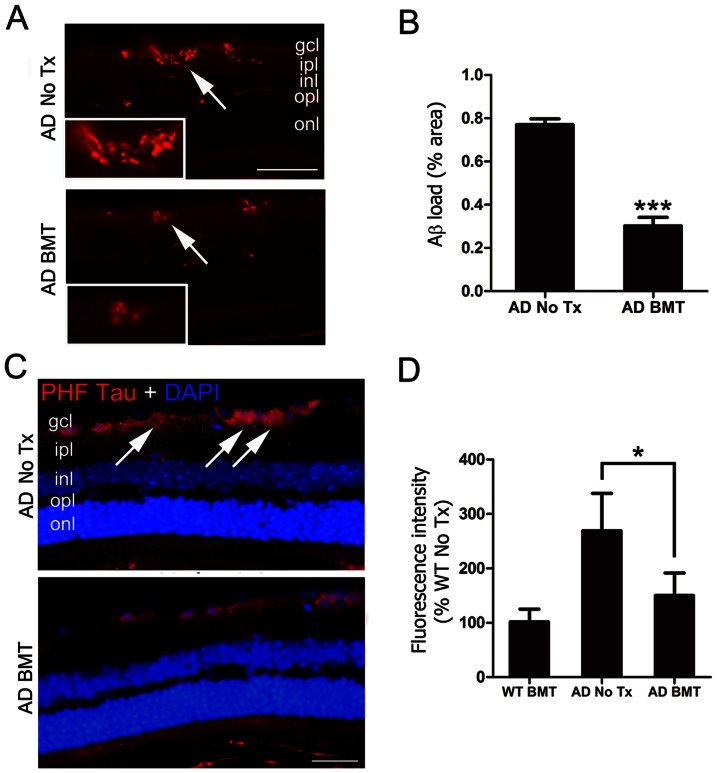
Aβ and PHF-tau are reduced in retina of APPswe-PS1ΔE9 BMT recipient mice.
A: Representative photomicrographs of Aβ deposition in non-transplanted, age-matched APPswe-PS1ΔE9 control retina (top, AD No Tx) or APPswe-PS1ΔE9 that received BMT (bottom, AD BMT) stained with anti-Aβ antibody and visualized with Cy3-conjugated secondary antibody (red). Region of inset is indicated by arrows. Scale bar  = 50 µm. B: Quantitative analysis of Aβ immunofluorescence using a standardized digital thresholding protocol demonstrated significant reduction in retinal Aβ in BMT APPswe-PS1ΔE9 mice compared with non-transplanted APPswe-PS1ΔE9 control mice (***P<0.001, n = 6, student's t test). C: Representative photomicrographs of PHF-tau immunofluorescence in retinal ganglion cell layer (RGCL) (arrows) of non-transplanted, age-matched control APPswe-PS1ΔE9 mice (top, AD No Tx) compared with APPswe-PS1ΔE9 BMT recipients (bottom, AD BMT). Nuclei were counterstained with DAPI (blue). Scale bar  = 30 µm. D: Quantitative analysis of PHF-tau immunofluorescence using a standardized digital thresholding protocol demonstrated significant reduction of PHF-tau in APPswe-PS1ΔE9 BMT-recipients compared with non-transplanted controls (*P<0.05, n = 6, one-way ANOVA analysis with Bonferroni post test).